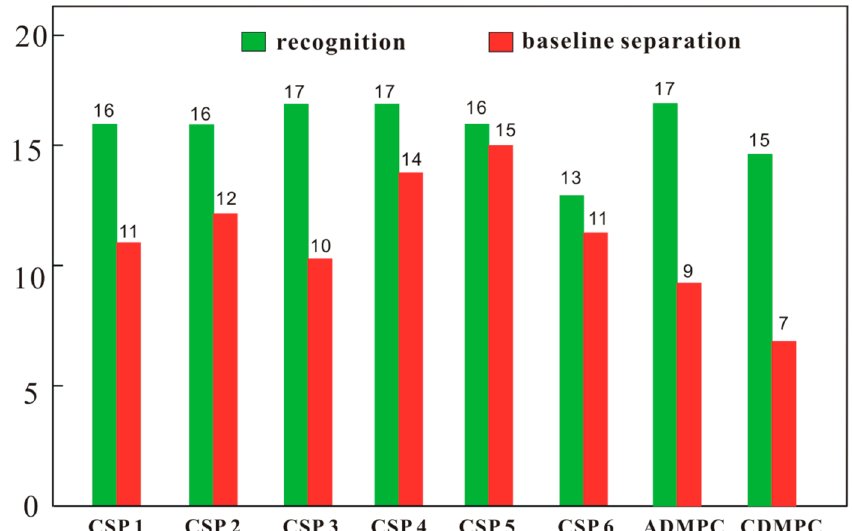
Figure 4. Total numbers of chiral analytes recognized and baseline separated by CSPs 1 – 6 , ADMPC and CDMPC in the mobile phases of n -hexane/isopropanol (90/10), n -hexane/ethanol (90/10) and n -hexane/ethanol/methanol (90/5/5). Column size: Φ 250 mm × 4.6 mm; flow rate: 1 mL/min; detection temperature: 25 °C.